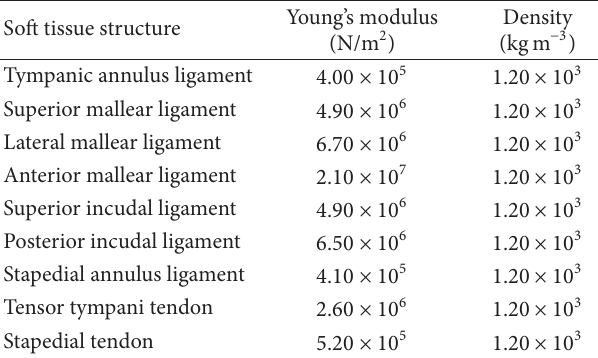
Table 2: Boundary conditions of the middle ear FE